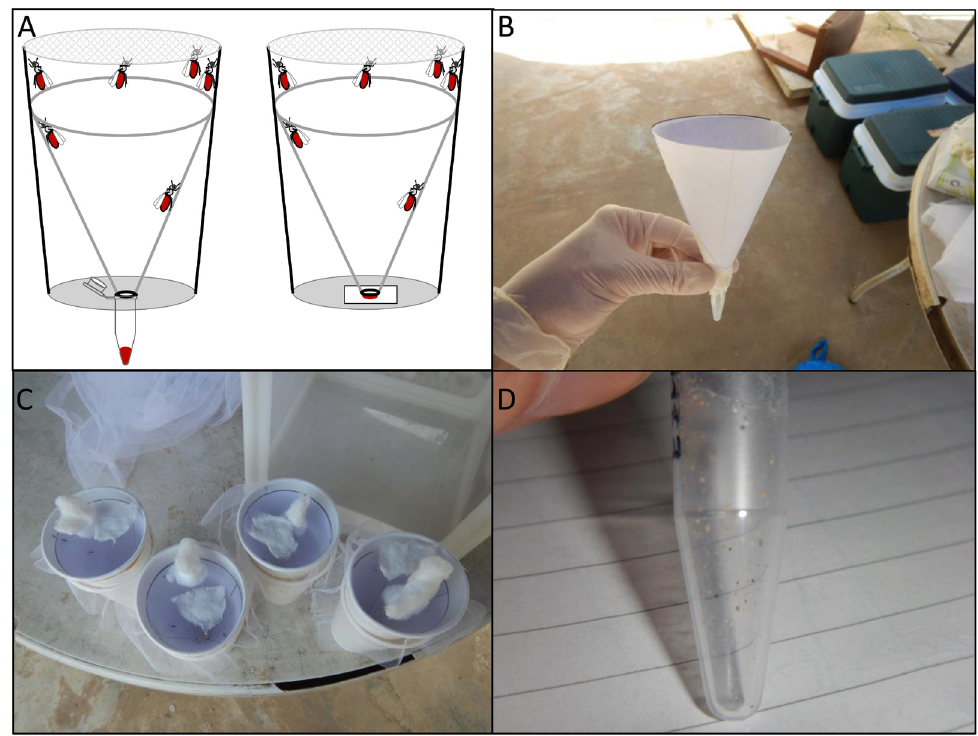
Figure 1. Schematic of the superhydrophobic cone and images from the field collections. ( A ) Schematic of the collection cups with the superhydrophobic cone used to collect excreta/feces (E/F) into a tube (left) or onto FTA card (right). From the field site - ( B ) the superhydrophobic cone being assembled, ( C ) wild-caught mosquitoes in the collection cups with superhydrophobic cones, ( D ) the resultant E/F in a collection